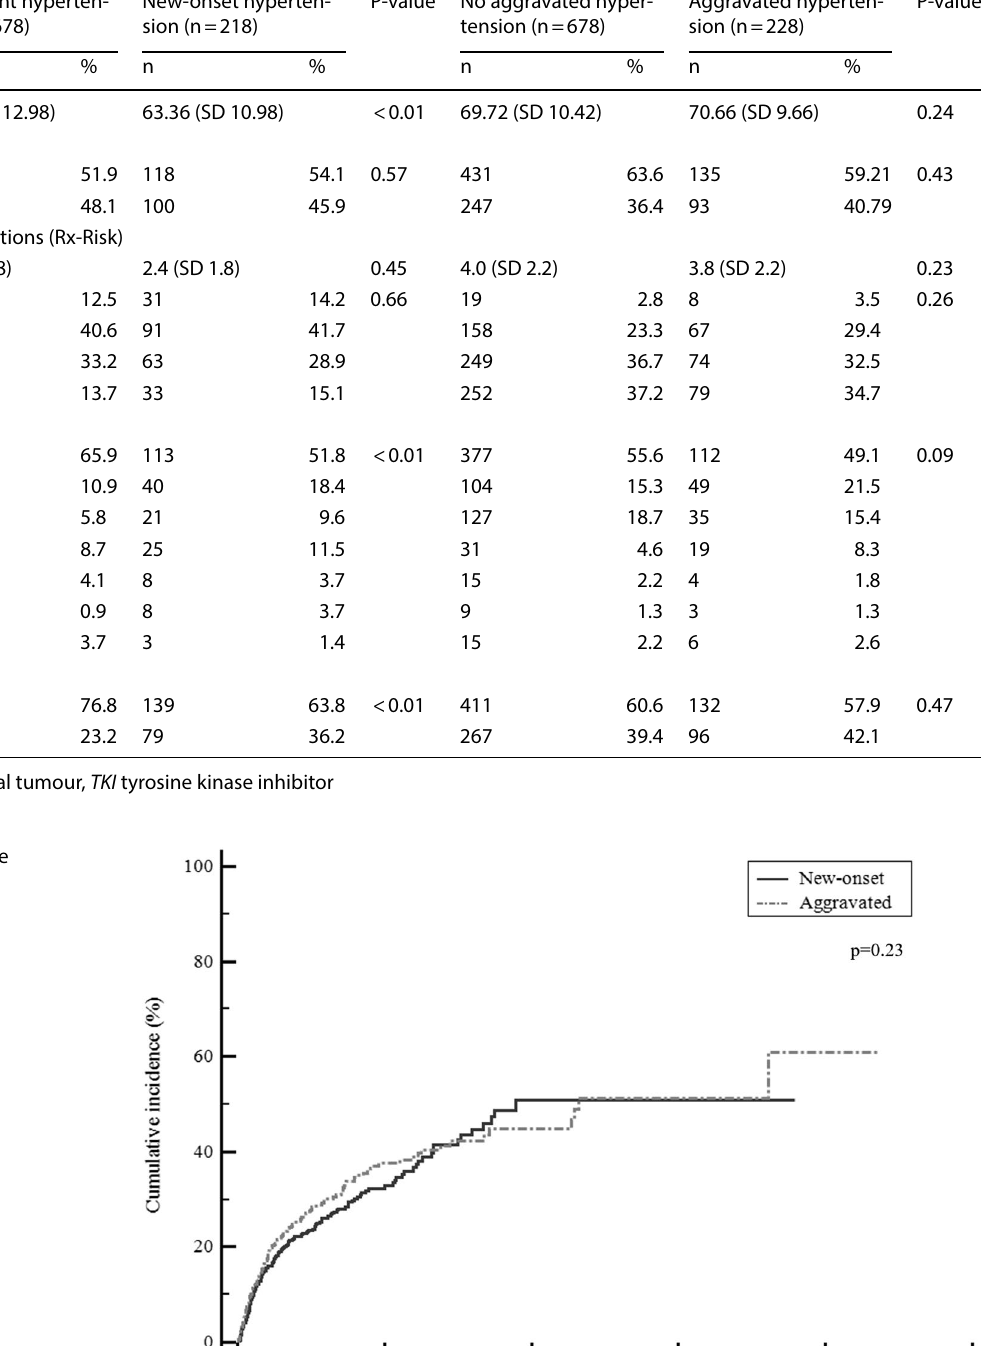
Table 2 Characteristics of VSPi cohort subgroups with and without pre-existing hypertension